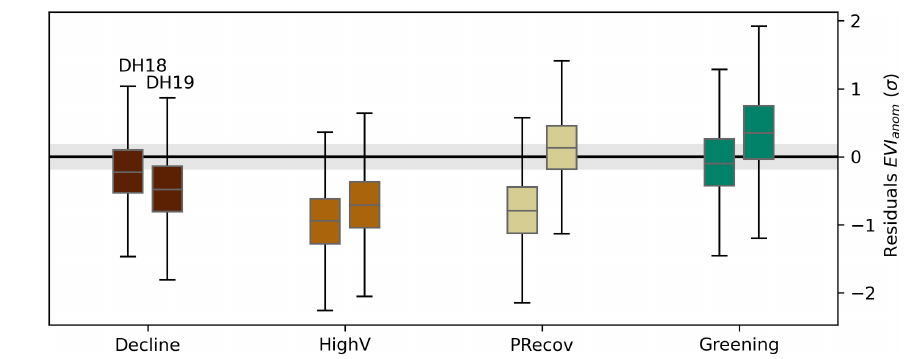
Figure B6. The same as in Fig. 5c but for the RF model trained using spring and summer SM anom and T anom as predictors, as well as − 1 EVI yr anom .